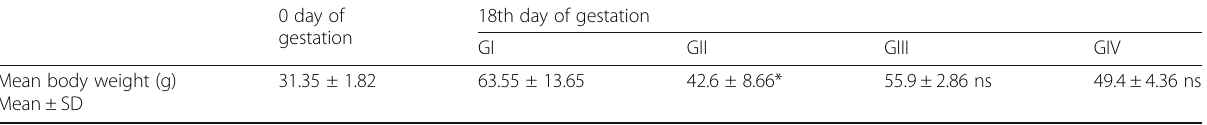
Table 1 Effects of olive leaf extract and/or STZ administration on the average increase in maternal body weight (g) during pregnancy